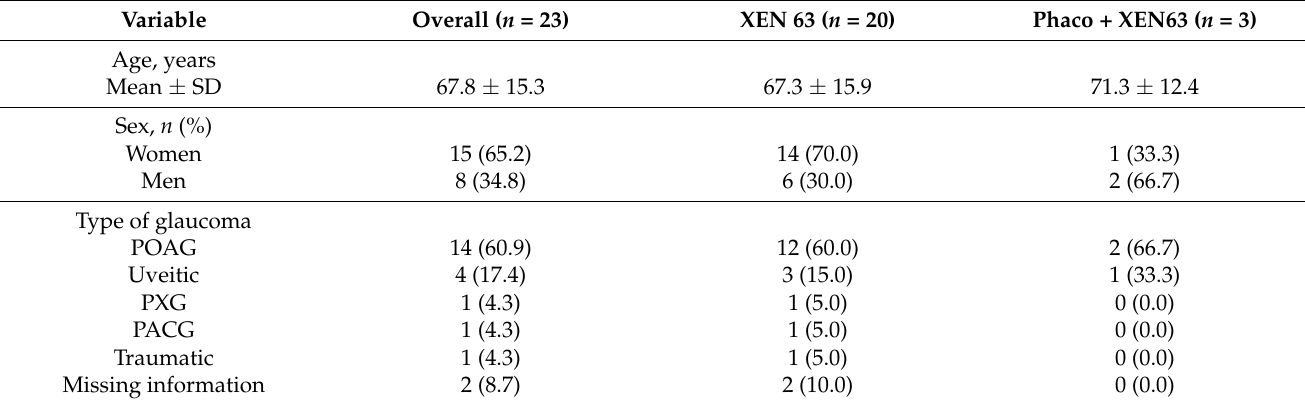
Table 1. Main baseline clinical and demographic characteristics of the study